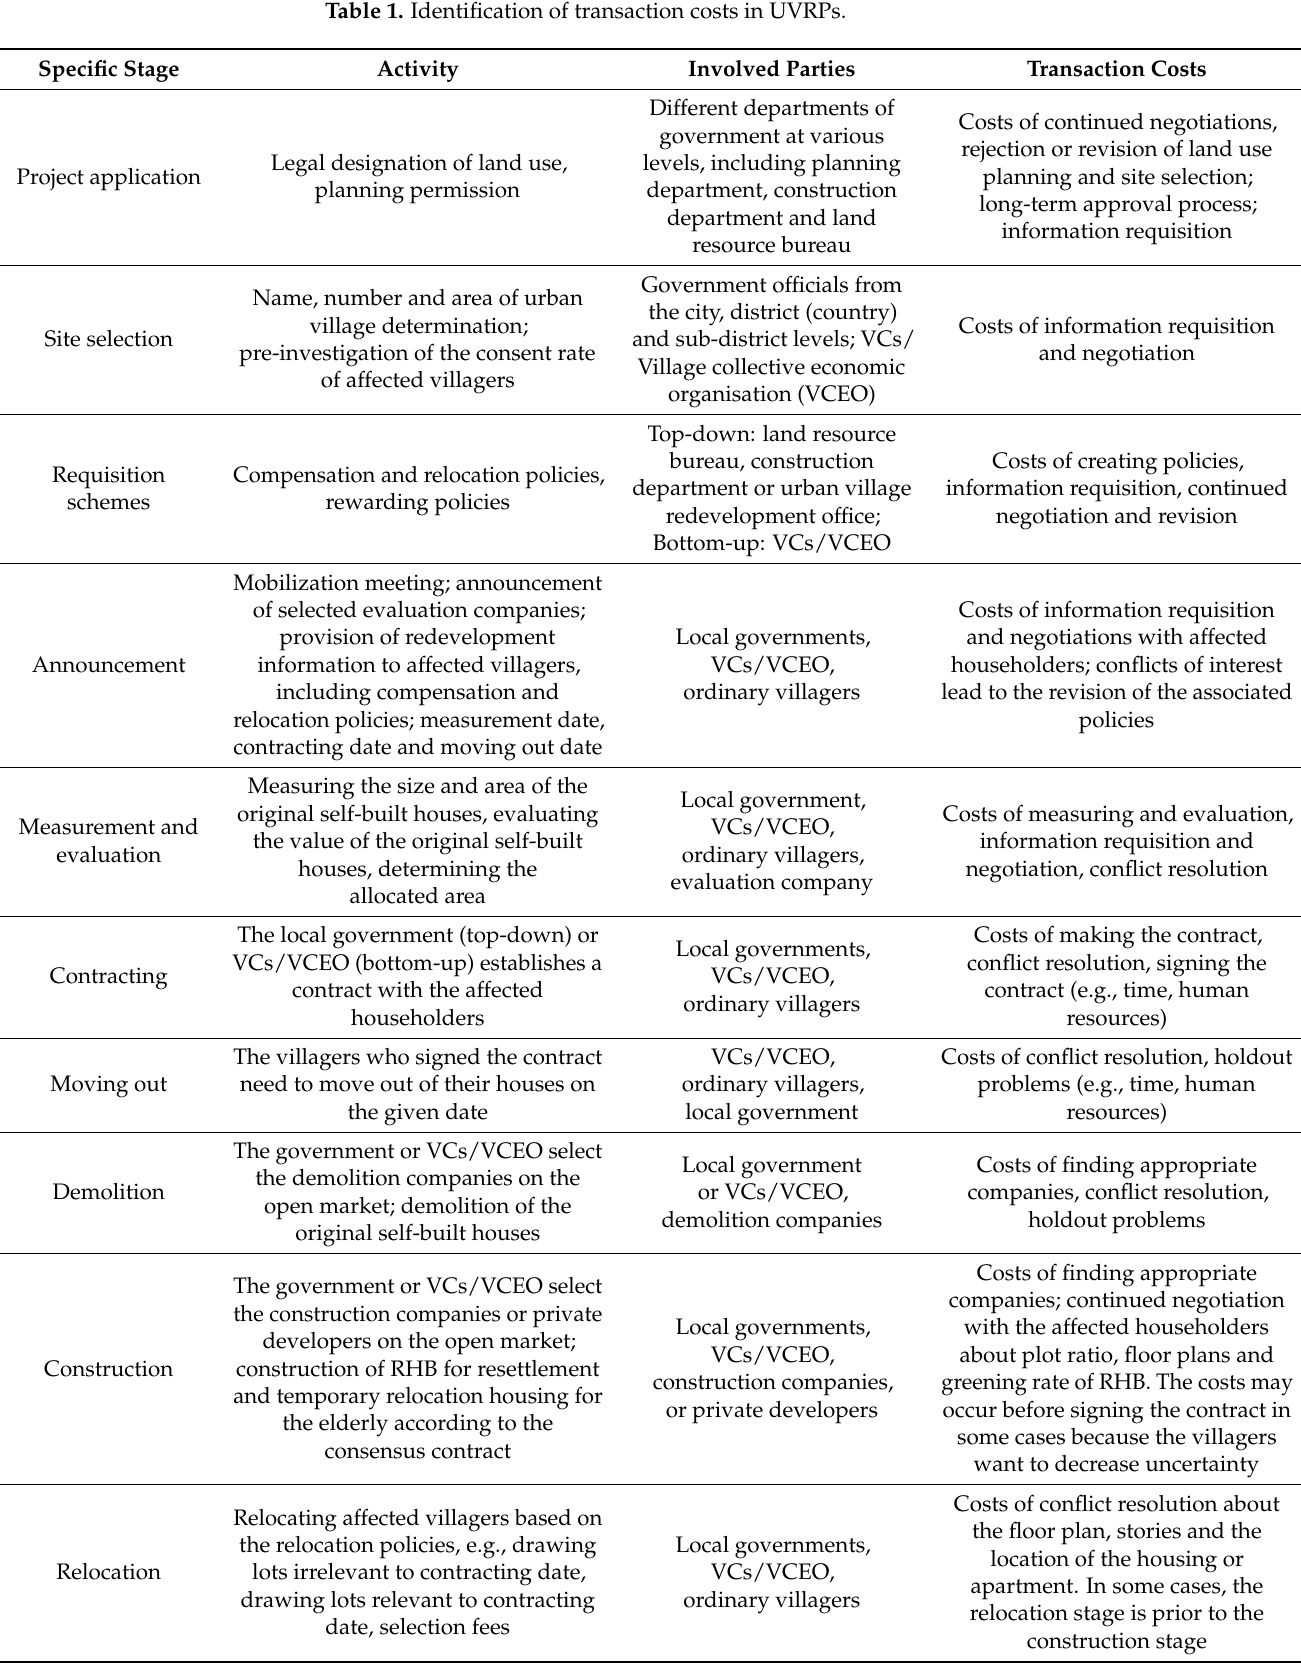
Table 1. Identification of transaction costs in